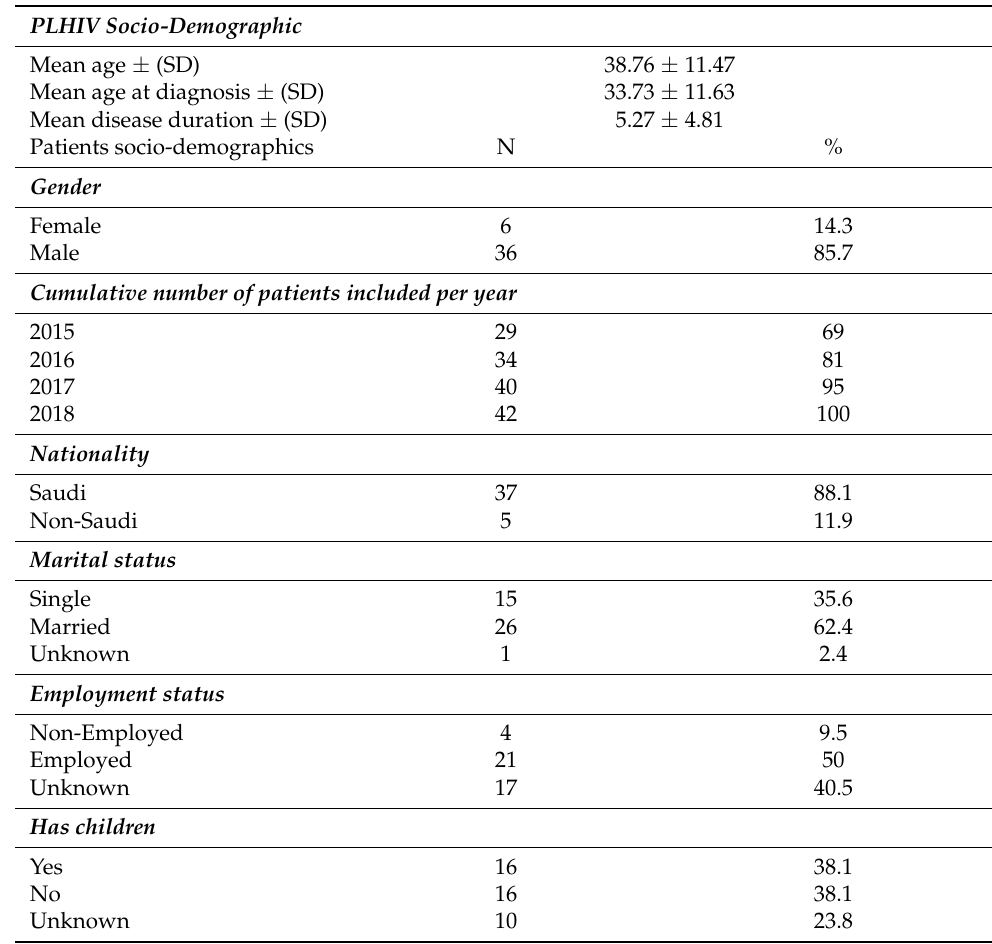
Table 1. Patients’